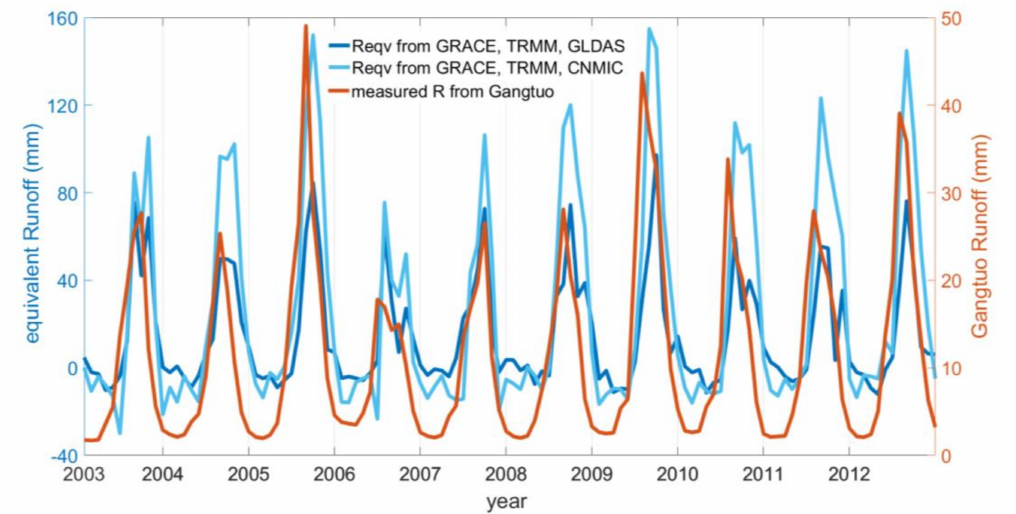
Figure 5. Equivalent runo ff derived from water balance equation method and measured runo ff at Gangtuo station. Table 2. The correlation coe ffi cients of each year’s in-situ runo ff and equivalent runo ff (two versions), corrected for time lags. Positive time lag indicates equivalent runo ff signals being ahead of the in-situ runo ff